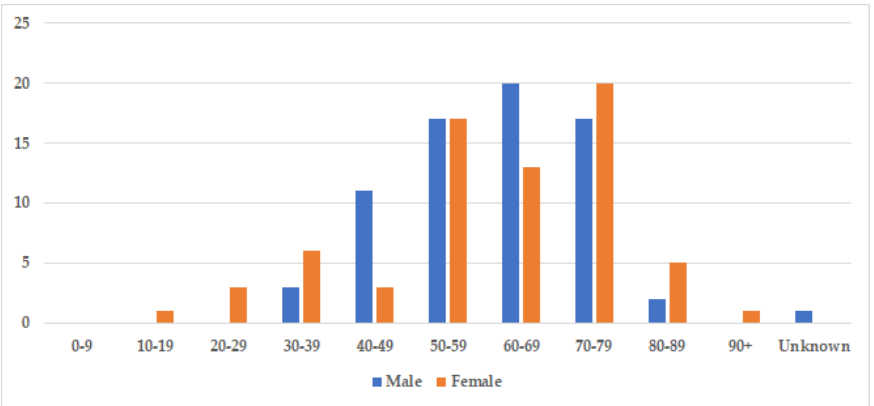
Figure 3. Age and gender distribution. The figure displays the incidence of storing histiocytosis in different decades. The median age at diagnosis was 60.5 years for both sexes (range 18–91, and slightly more cases were identified amongst men with 71 men (51%), compared to 69 women (49%).